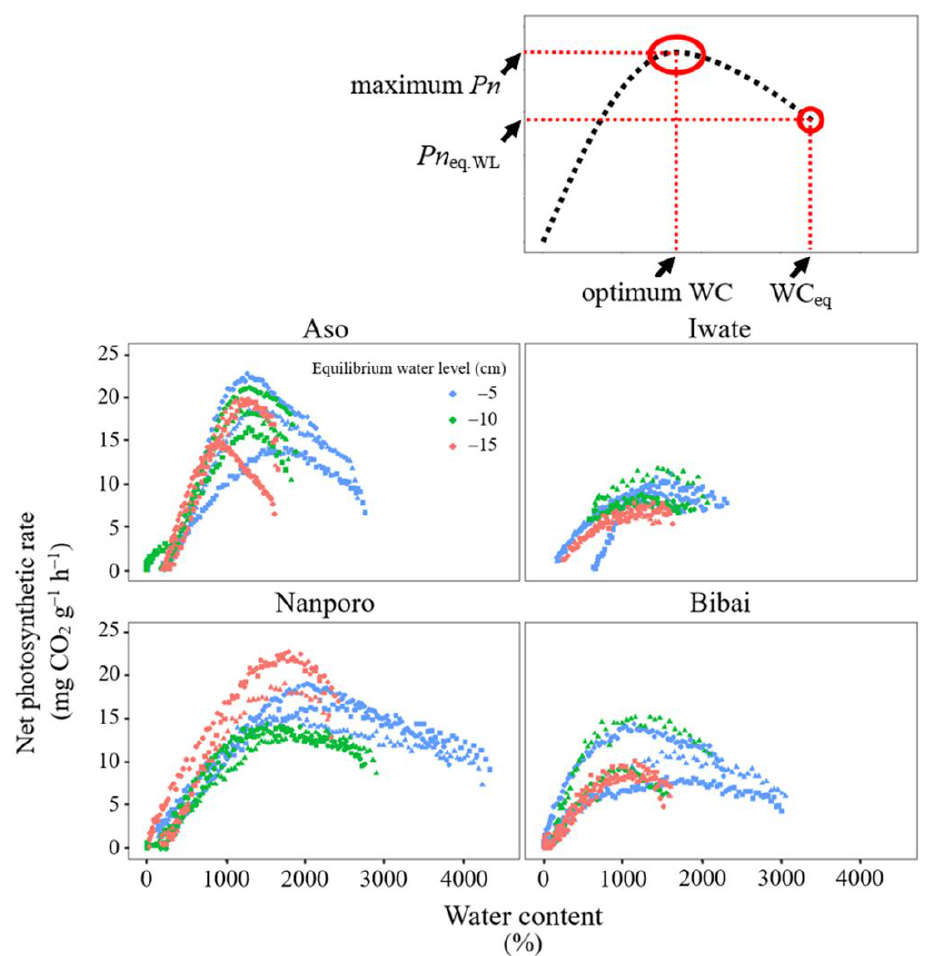
Figure 5. Relationships between gravimetric water content (WC) and net photosynthetic rate ( Pn ) of Sphagnum palustre from the various collected regions. Pn was measured at 25.0 ± 0.5 °C under saturated light (PPFD 500 μmol m -2 s -1 ). Different symbols (closed circle, triangle and square) represent results for different